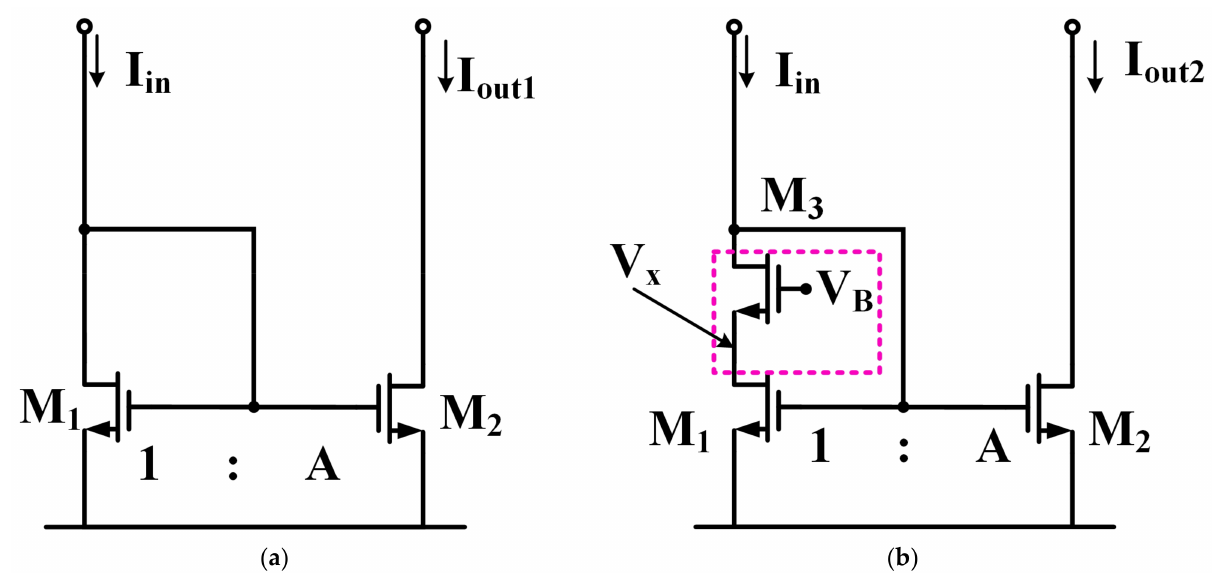
Figure 4. ( a ) Classical current mirror (CM); ( b ) Nonlinear current